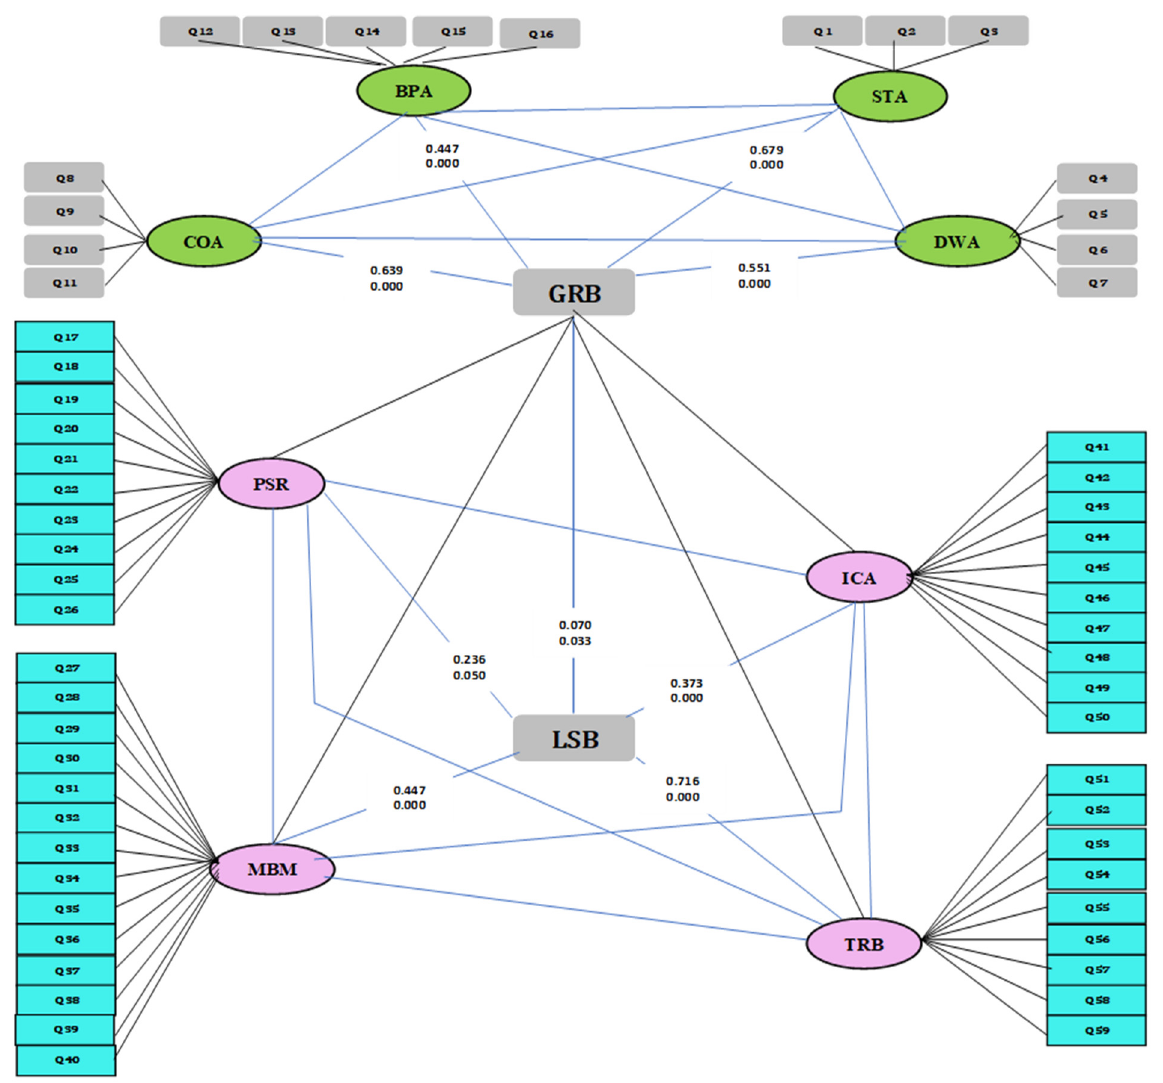
Figure 2. The modality and hidden effect of research. Table 10. The fit of the main research